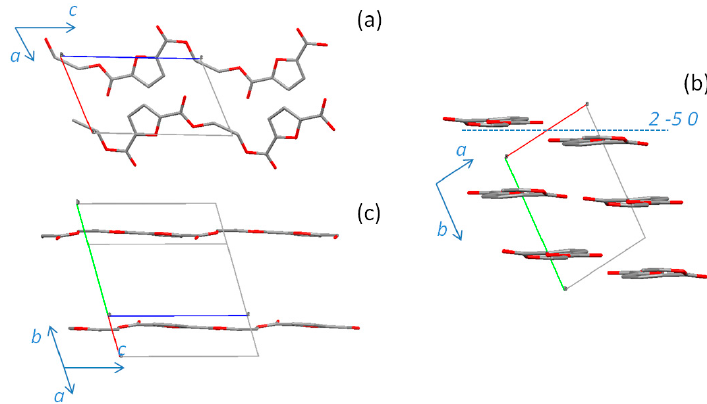
Figure 3. Views of the chain arrangements in the unit cell for the α -PEF structure: ( a ) along the b -axis; ( b ) projection down the c -axis; ( c ) a view to highlight chain section. Oxygen atoms are in red; dotted line represents the intersection of the 2 -5 0 plane with the a , b plane.